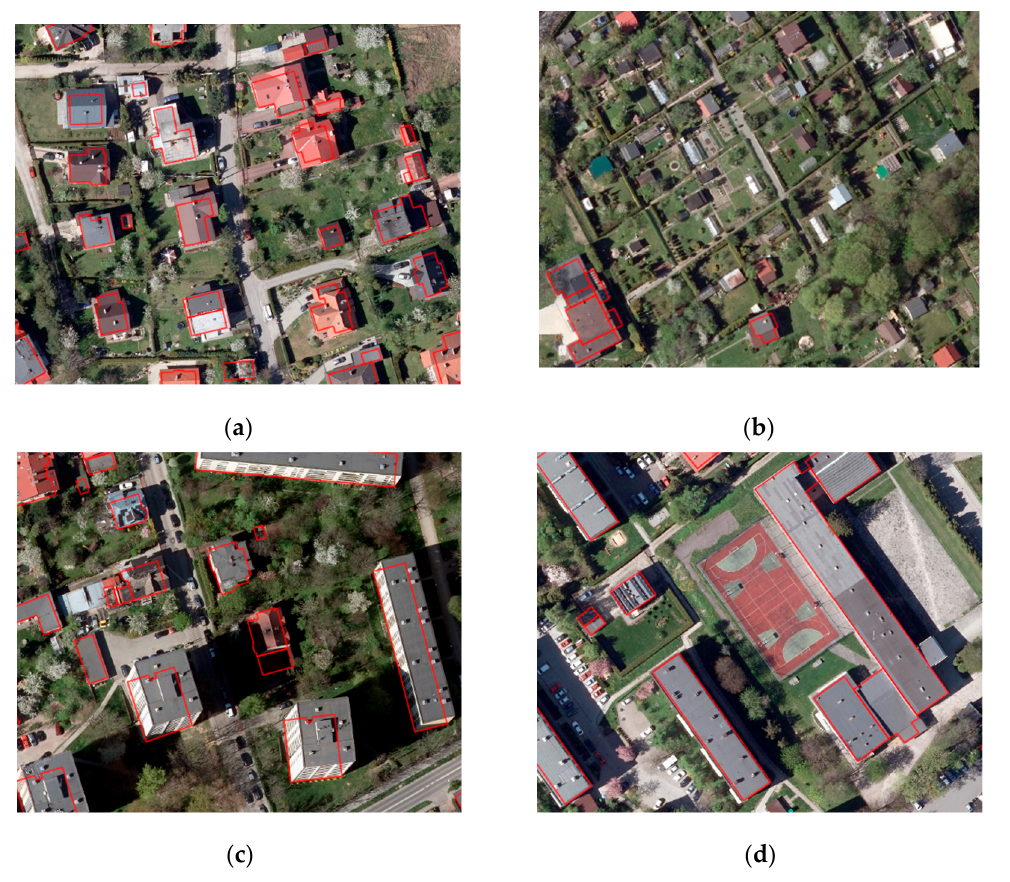
Figure 2. Identified errors for input data. Red colour marks outlines of buildings from the cadastral database. The images represent, respectively, the problems: ( a ) outline along the building walls—not along the roof, ( b ) gaps in the EGiB database, ( c ) radial displacement for tall buildings, ( d ) correct outline.